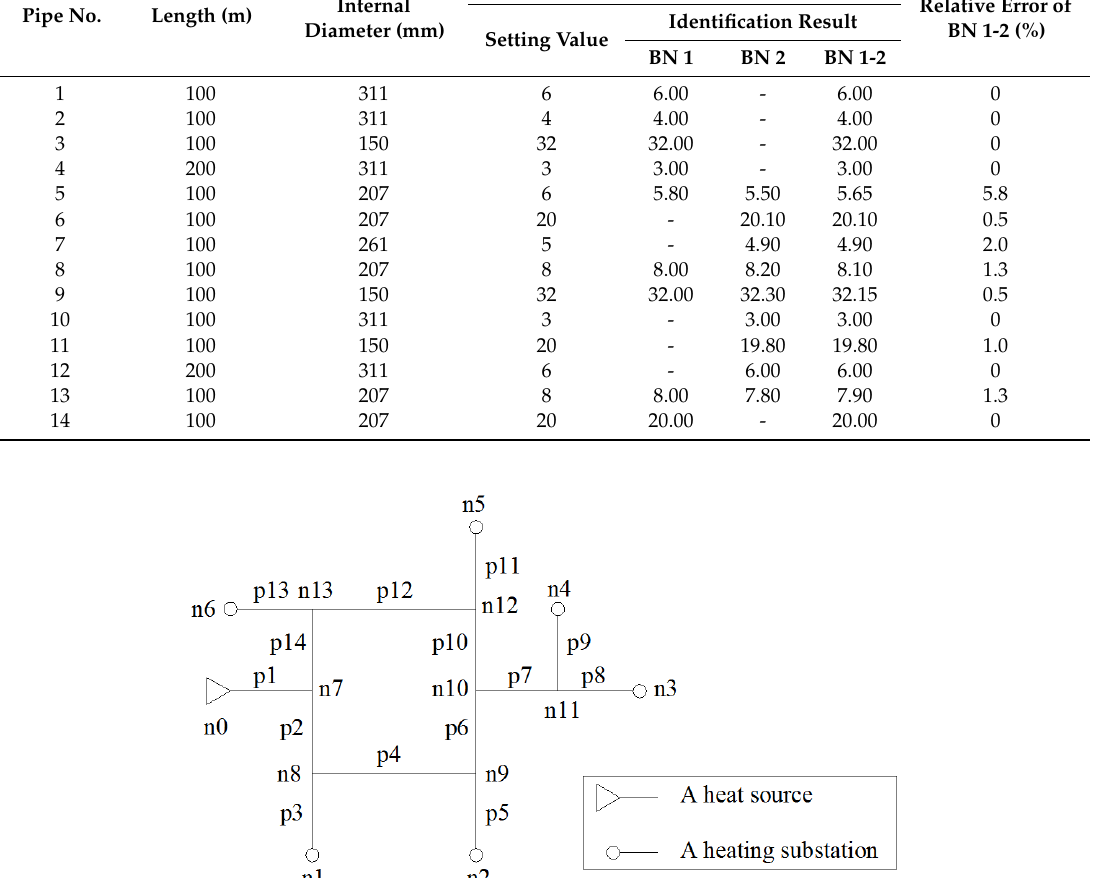
Table 5. Pipes information and PHRs identification results of the example loop DHN.